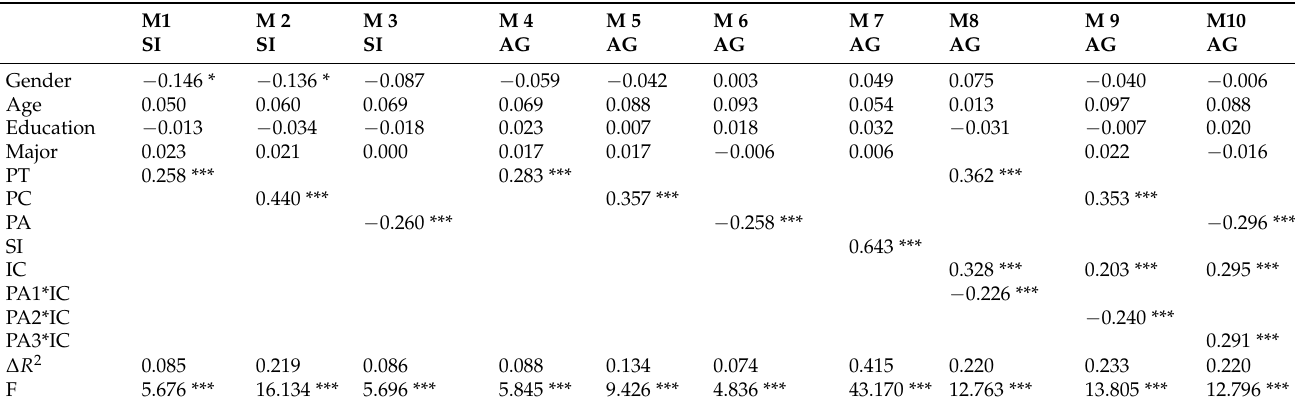
Table 2. Hierarchical Regression Results (N =